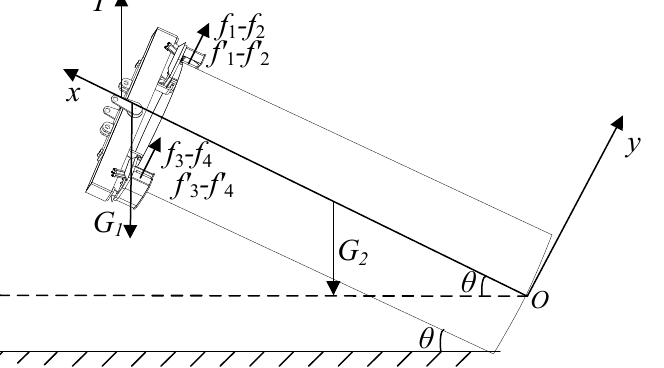
Figure 7. Stress Condition of Foundation Pile during Lifting Process.